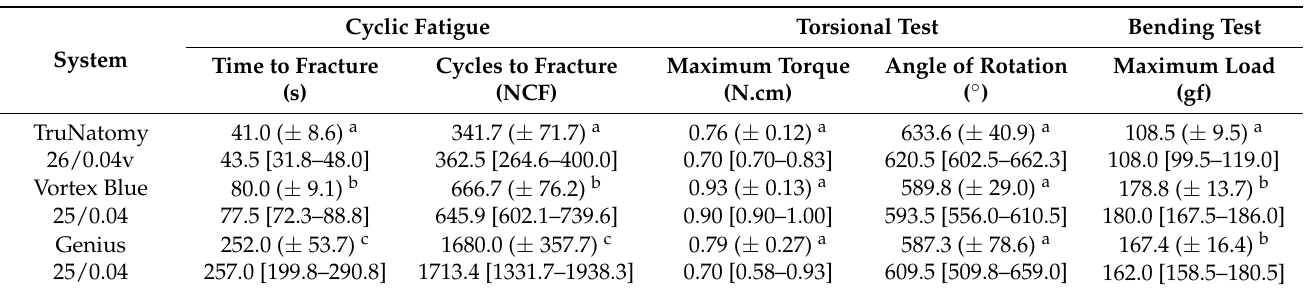
Table 1. Mechanical behavior of tested instruments shown as mean (standard deviation) and median (interquartile range) values.